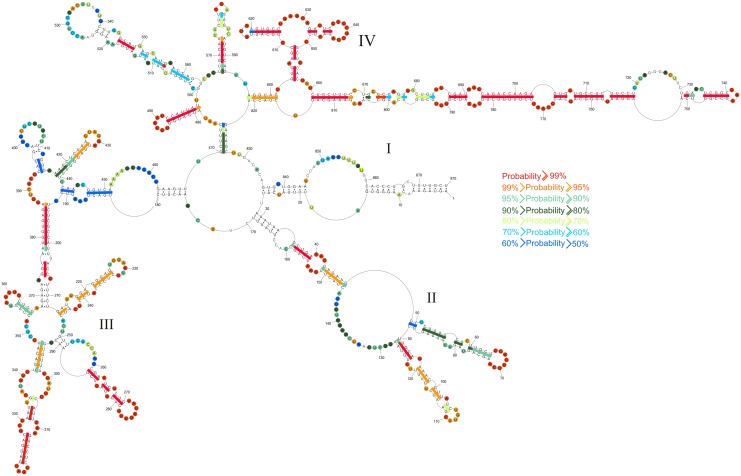
RNAstructure5.3 predicted probability of nucleotides being paired (colored lines) or single stranded (colored circles) in vRNA8 self-folding.Probability lower than 50% is not colored. The partition function calculation incorporated restraints from strong reactivity of DMS, consensus basepairs from sequence and structure analysis and SHAPE reactivities converted to pseudo-energy.